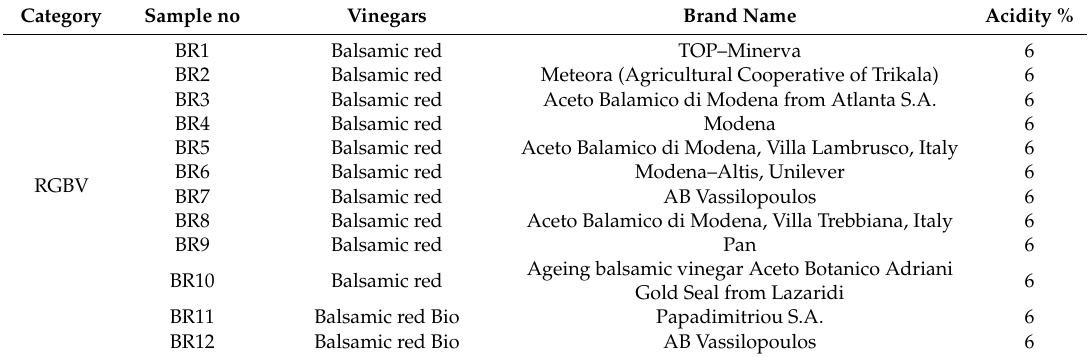
Table 1. Labelling of vinegar